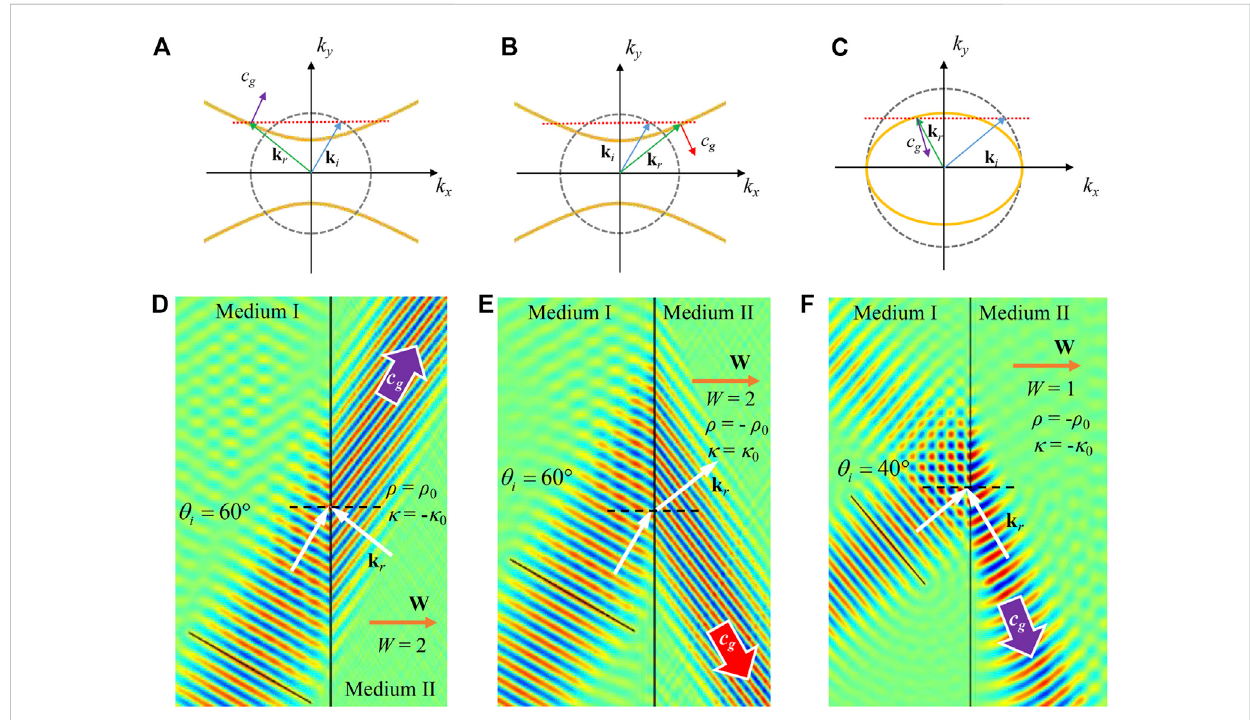
FIGURE 3 Interface refraction of Willis media with negative parameters. (A), (B), and (C) Slowness curves of the medium on the incident side (the gray dashed) and the refractive side (yellow solid). Blue and green arrows are the incident and refractive wave vectors, with equal tangential components indicated by thered dotted line. The red or purple arrowsindicate thedirection of group velocities. (D), (E), and (F) Corresponding FEMsimulations ofthe cases of (A), (B), and (C) , respectively, (pressure fi eld).